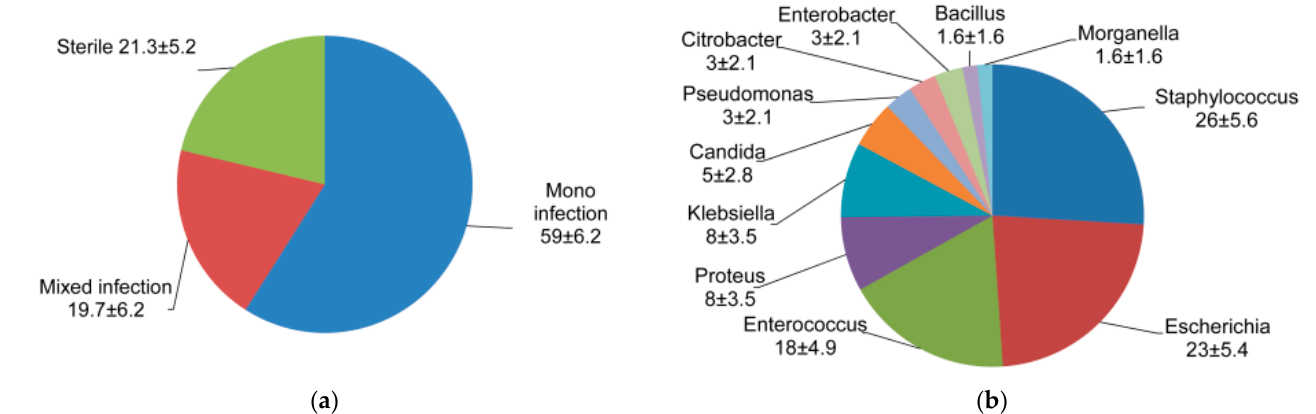
Figure 3. Microorganisms isolated from renal calculi. Frequency of contaminated calculi ( a ) and the species accumulation chart of microorganisms ( b ).